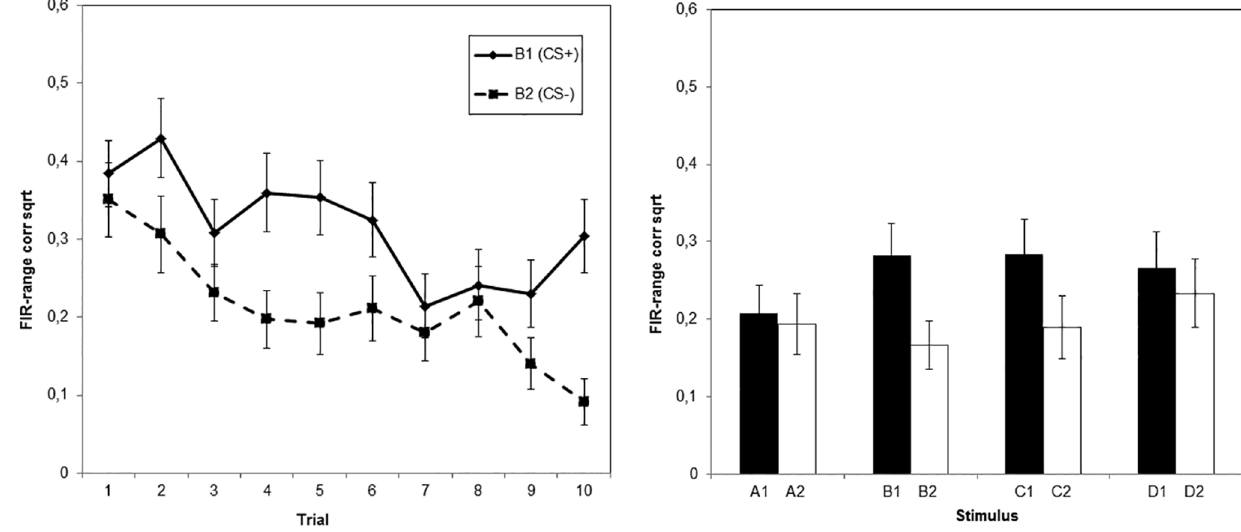
Figure 4. Mean skin conductance responses over the acquisition phase and generalization of acquisition test. Responses were range- corrected and square-root transformed. The left panel represents the data from the acquisition phase, per trial, for both the CS + (B1) and the CS 2 (B2). The right panel shows the data from the generalization of acquisition test of all stimuli from both categories. Each stimulus was presented once during this